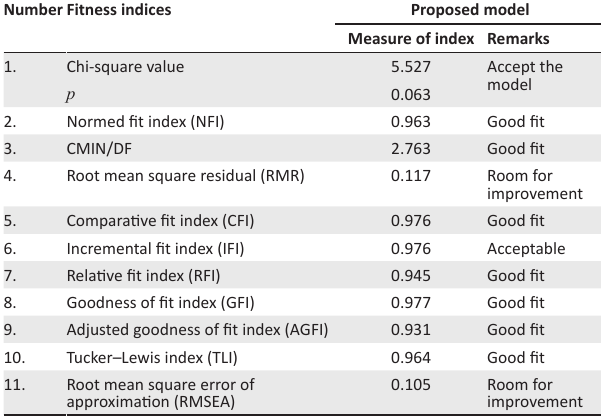
TABLE 6: Fit indices for the proposed model of